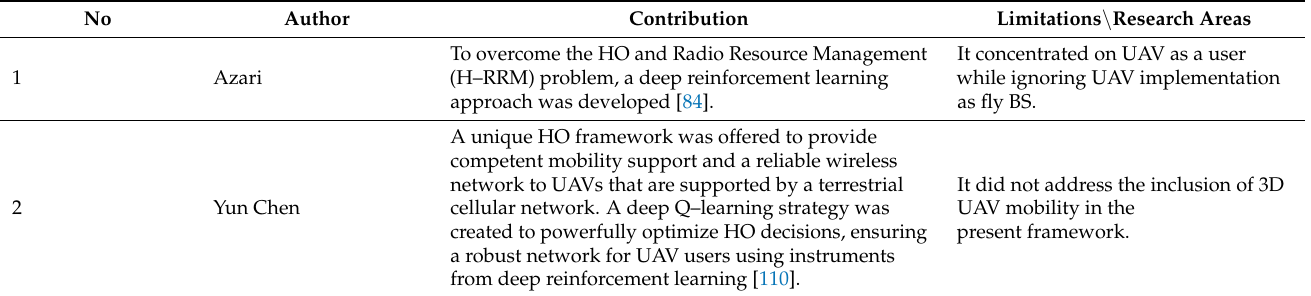
Table 3. Summary of previous